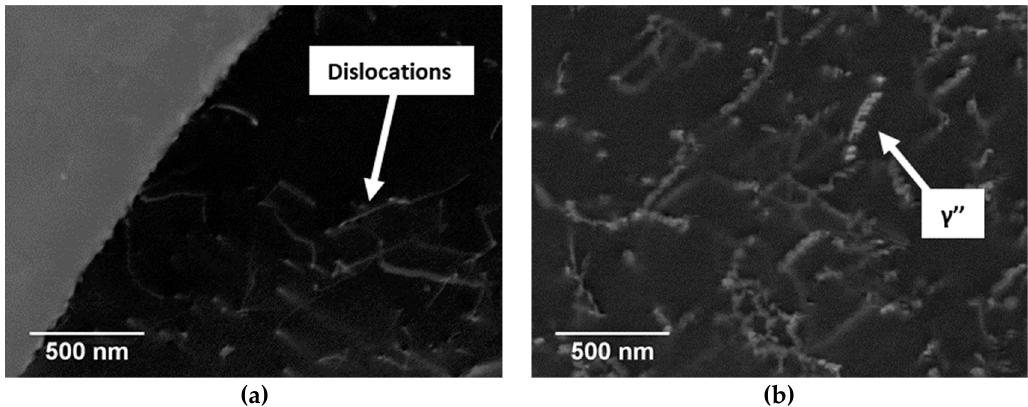
Figure 11. Segregation band of the sample hot rolled at 1050 °C with the deformation level of 23.5% and aged at 750 °C for 25 h ( a,b ). The precipitation of the γ ’’ in the segregation band of the deformed grain ( c ) and the recrystallized grain ( d ). The difference between the precipitation at the edge of the segregation band in the deformed ( e ) and the recrystallized grain ( f ).